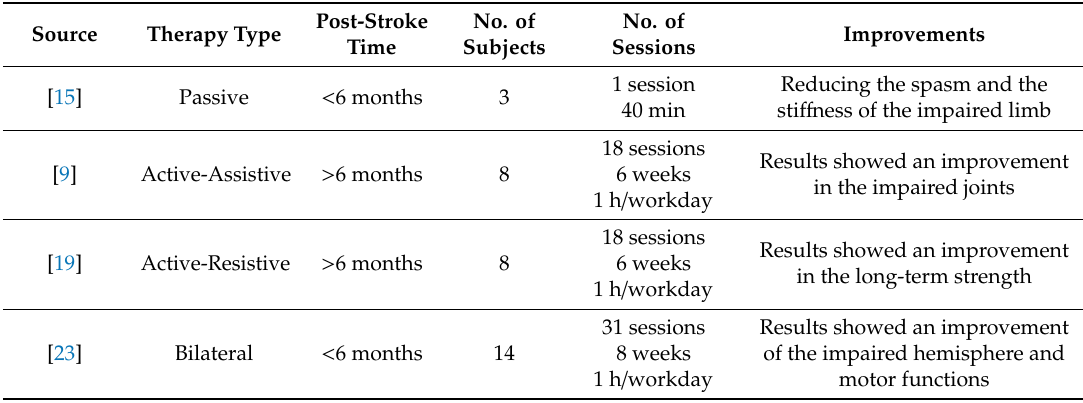
Table 2. Summary of the therapy types in terms of the clinical results.